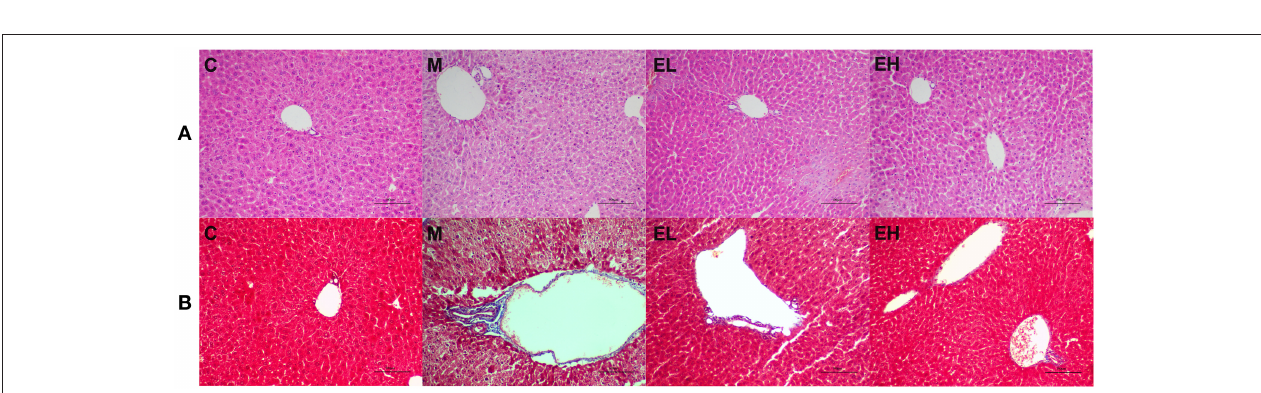
FIGURE 4 | Effect of ellagic acid on hepatic oxidative stress parameters in mice. (A) MDA; (B) SOD; (C) GSH-Px; (D) GSH; (E) CAT. Values represent the mean ± SD ( n ≥ 6). Labeled means without a common letter difference. p < 0.05 by one-way ANOVA followed by Duncan’s test. C, normal group; M, model group; EL, low dose of ellagic acid group; EH, high dose of ellagic acid group.